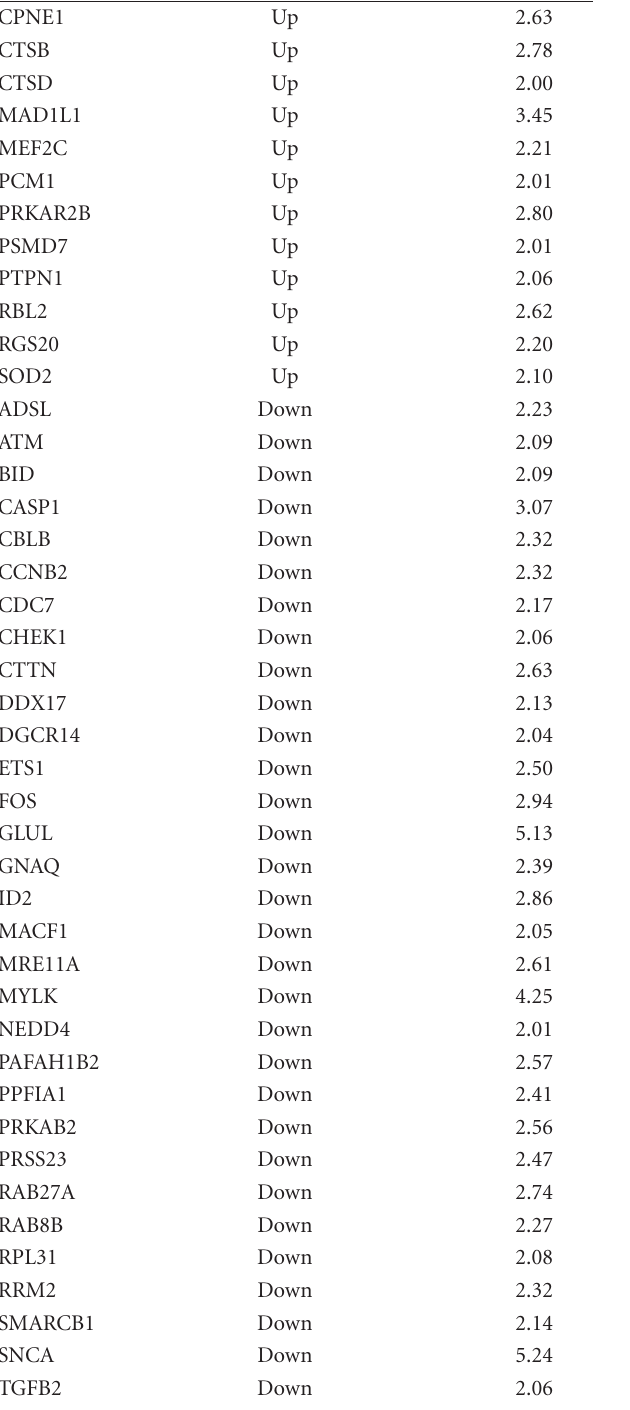
Table 3: The important set of genes based on topological structure of interaction network. Selecting the nodes that satisfy condition 2 (the articulation nodes among the hub nodes of the network) and condition 3 (the hub nodes of the minimum spanning tree). The inverse of fold changes for down regulated genes is shown. Thus the table includes the genes that are not considered in the experiment or neither up-or downregulated.